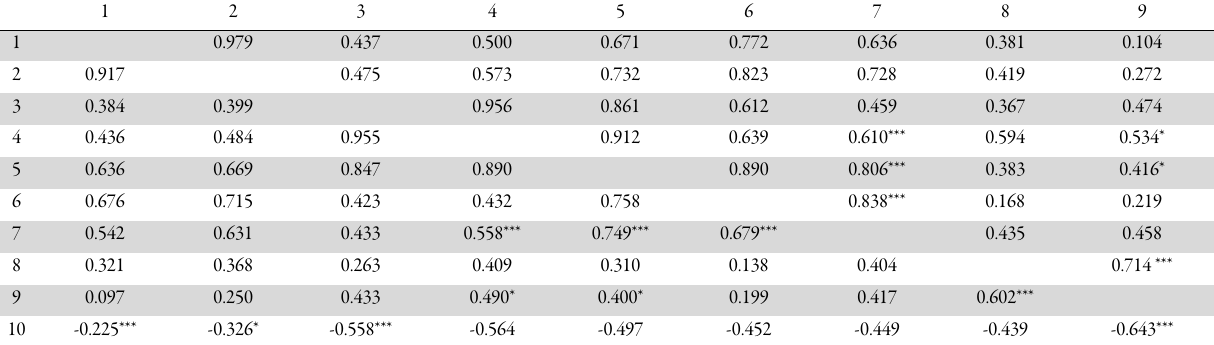
Table 5. Genotypic (above the diagonal) and phenotypic (under the diagonal) correlation coefficients (r) for the studied traits in white lupine cultivars